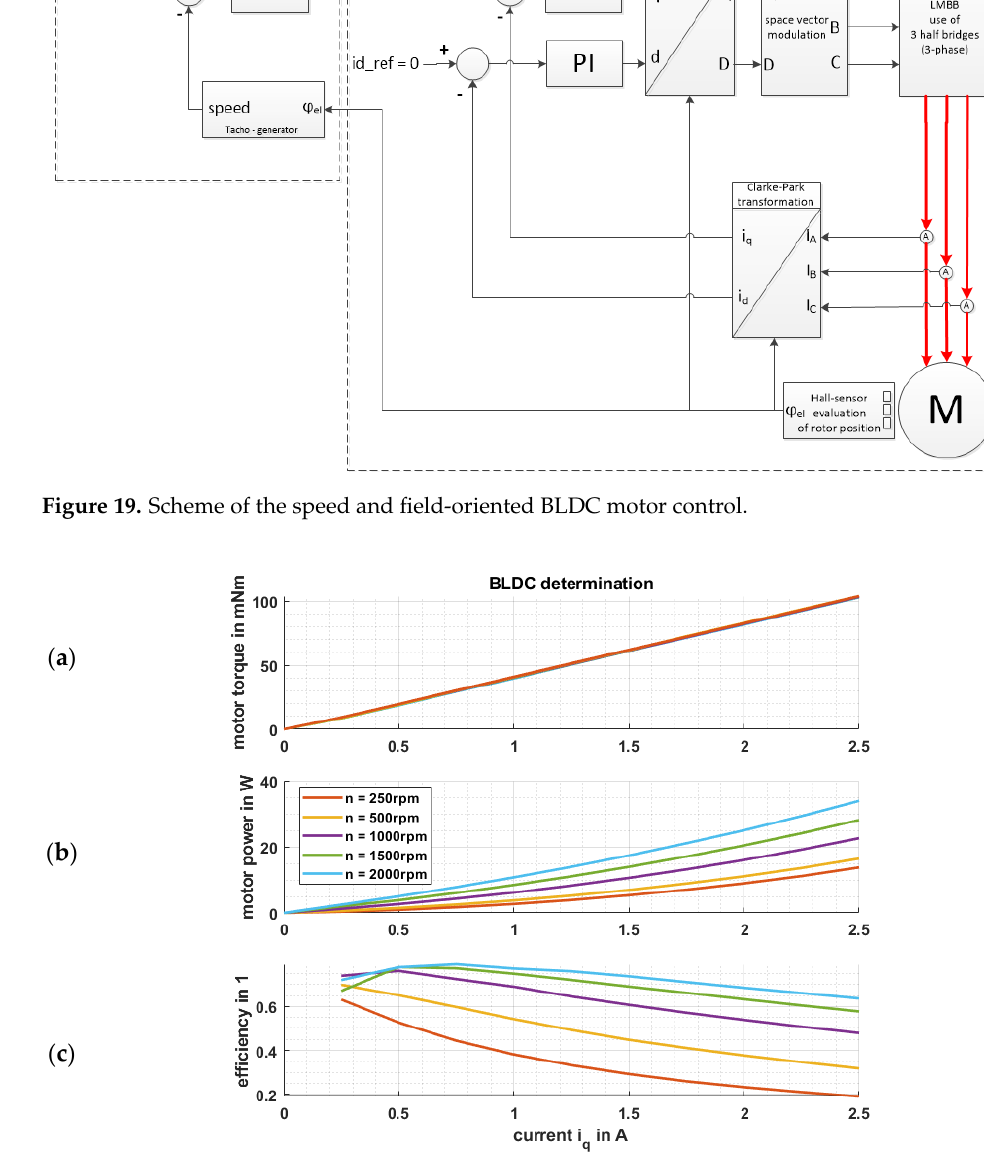
Figure 20. BLDC motor performance determination: ( a ) effects of motor speed and q-current variation on motor torque; ( b ) power consumption of the BLDC-motor at certain speeds and loads; ( c ) calculated efficiency graph of the BLDC-motor.